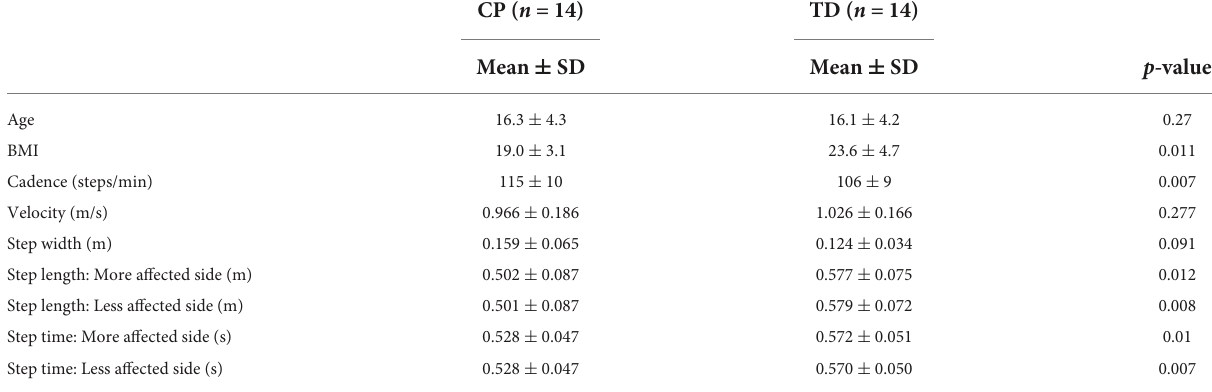
TABLE 2 Mean, standard deviation (SD), and p -values for the difference between the CP ad TD groups for demographic and spatiotemporal gait